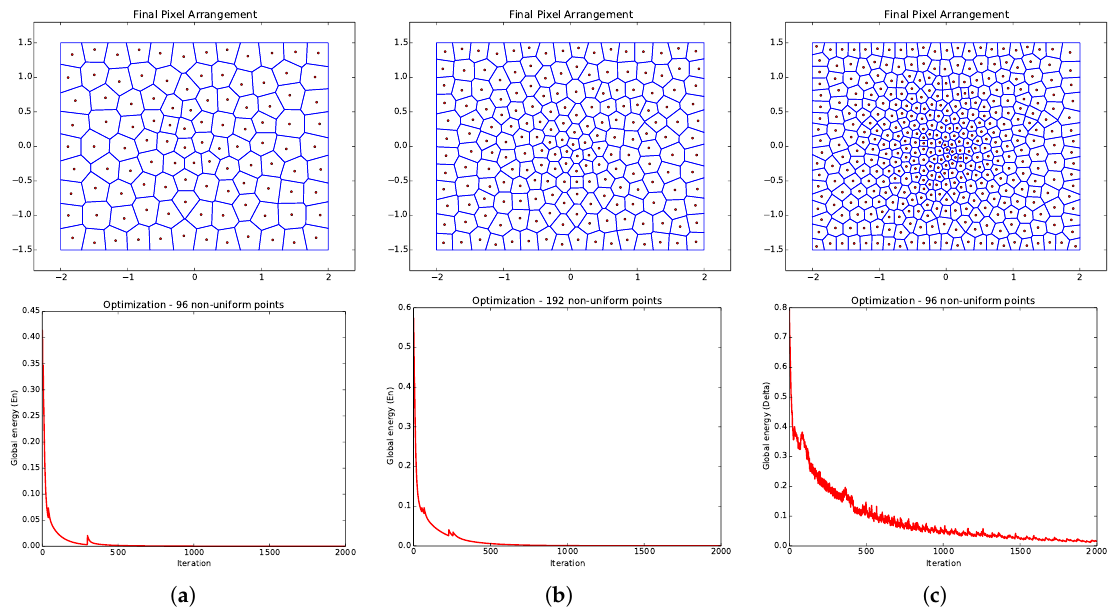
Figure 4. Convergence analysis for ARIMs with no fovea and based on the l 2 implicit function. Examples of ARIMs containing ( a ) 96, ( b ) 192, and ( c ) 384 non-uniform points in the periphery. For each ARIM, the resulting global energy curve over 2000 iterations of the generation process is shown in the model’s respective column.